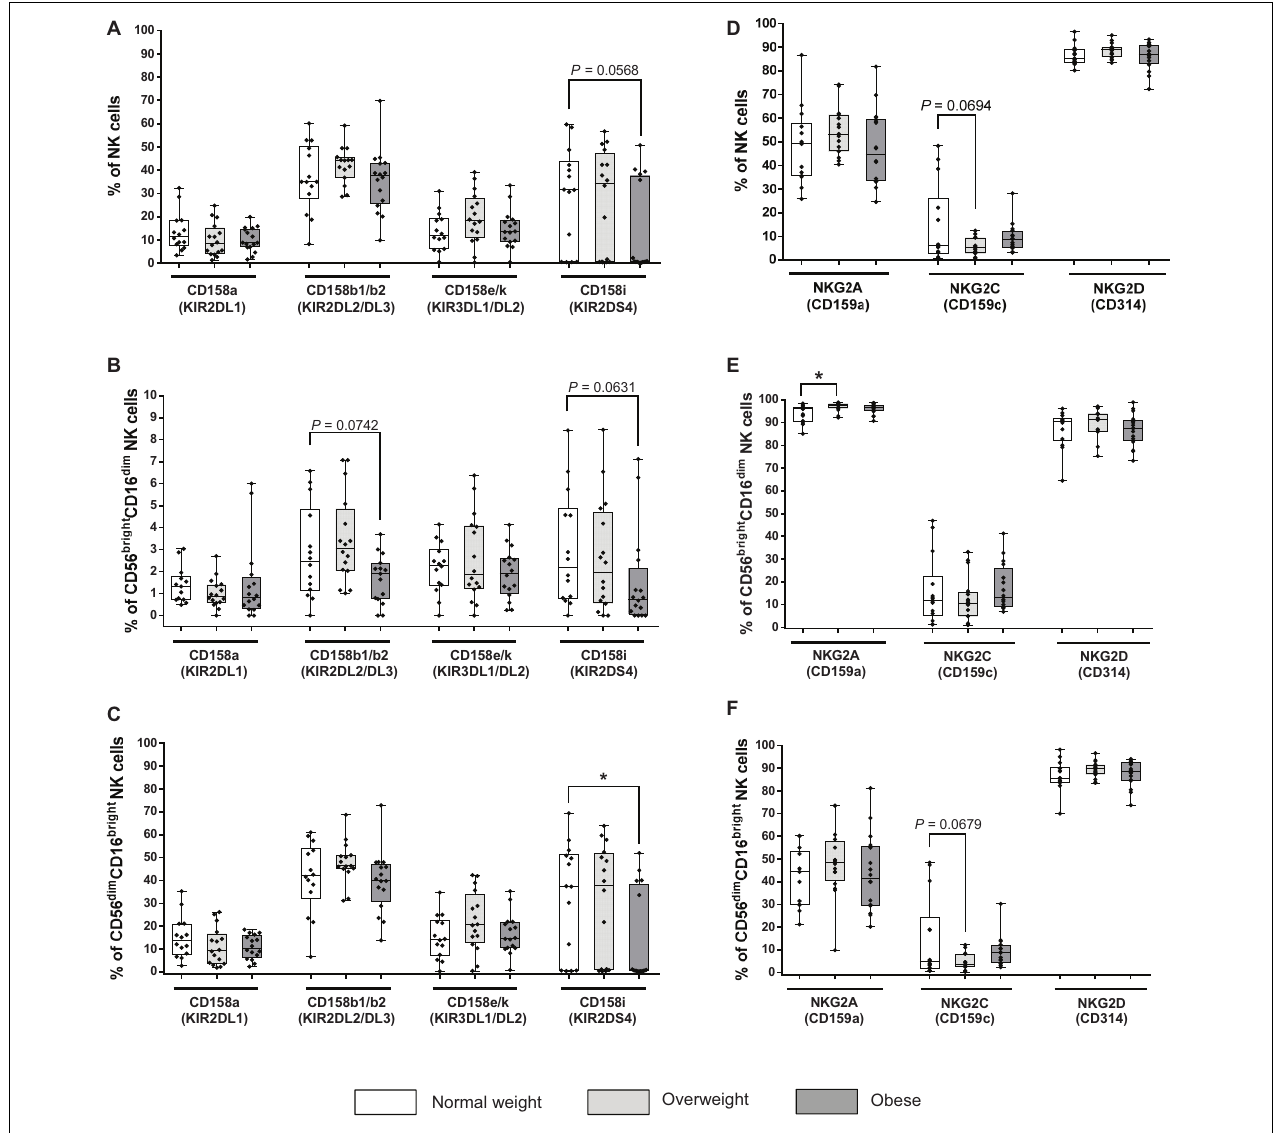
FIGURE 2 | Frequencies of NK cells and NK cell subsets expressing killer-cell immunoglobulin-like receptors (KIRs, A–C ) and C-type lectin receptors (CTLRs, D–F ) in peripheral blood mononuclear cells (PBMCs) isolated from normal weight ( n = 14), overweight (n = 16) and obese (n = 16) healthy blood donors. (A–C) Percentage of KIR + total NK cells (A) , CD56 bright CD16 dim NK cells (B) , and CD56 dim CD16 bright NK cells (C) . KIRs named on X-axes are inhibitory (CD158a, CD158b1/b2, CD158e/k) and activating (CD158i) receptors on NK cells. (D–F) Percentage of CLR + total NK cells (D) , CD56 bright CD16 dim NK cells (E) , and CD56 dim CD16 bright NK cells (F) . CTLRs named on X-axes are inhibitory (NKG2A) and activating (NKG2C, NKG2D) receptors on NK cells. Graphs are box and whisker plots with median ± minimum to maximum value; with additional dot plot representing individual donors. Overweight and obese groups were compared to normal weight control groups. Statistical significance is indicated as: * P ≤ 0.05; exact P -values within 0.05 ≤ P ≤ 0.1 are